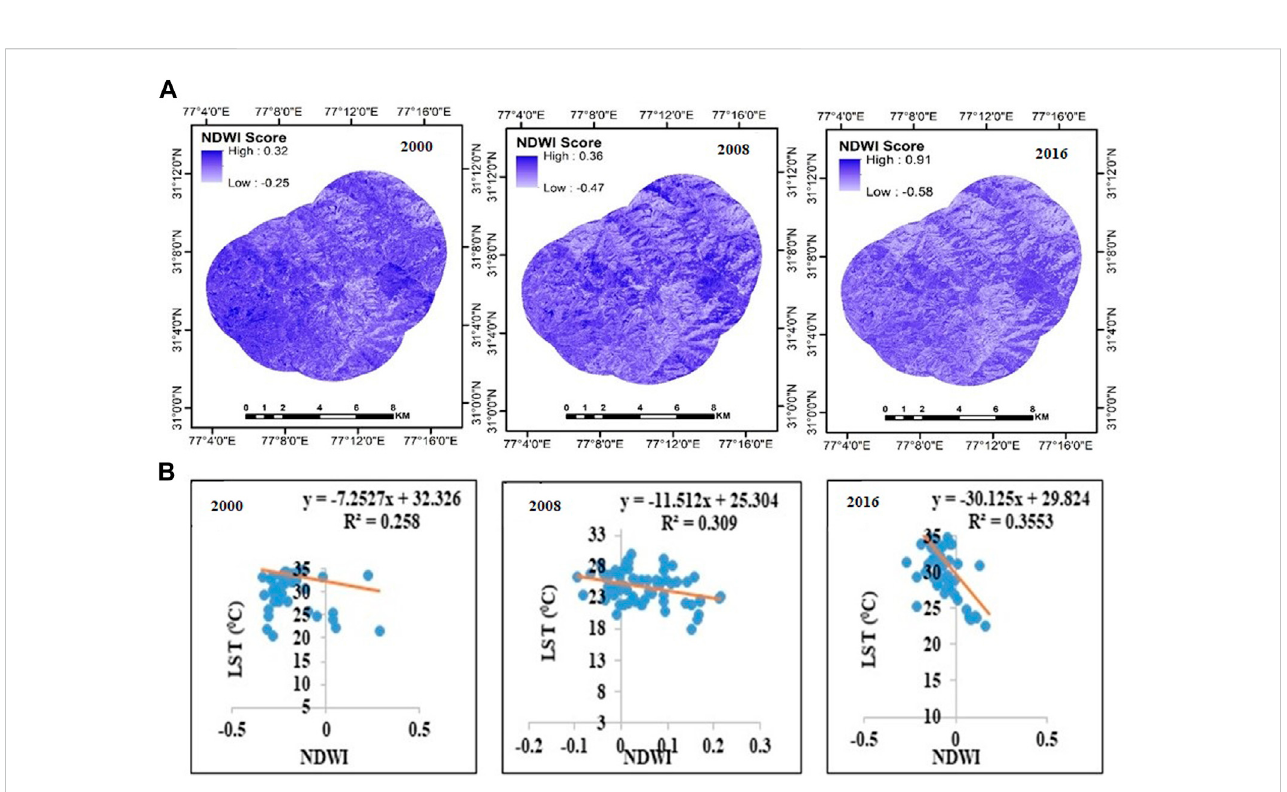
FIGURE 9 Change in NDWI (A) and degree of association of NDWI with LST (B) for Shimla.